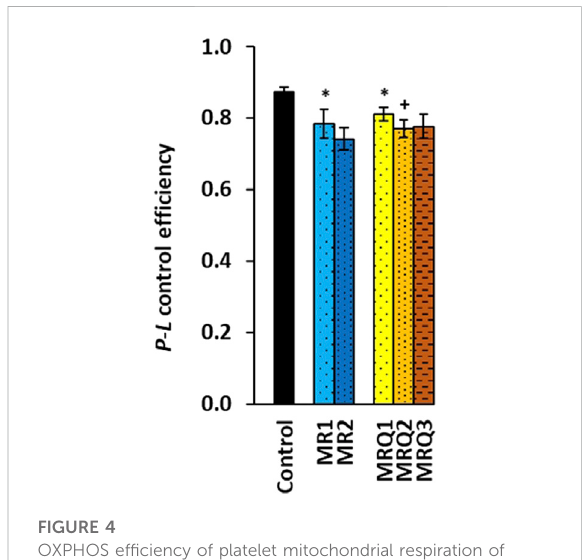
FIGURE 4 OXPHOS ef fi ciency of platelet mitochondrial respiration of patientswithpostC-19. P-L controlef fi ciencywascalculatedfrom parameters of mitochondrial respiration as (2D-1PM)/2D (for parameters and groups refer to Figure 3). * p < 0.05 vs. Control. + p < 0.05 vs. the same group at the beginning of the